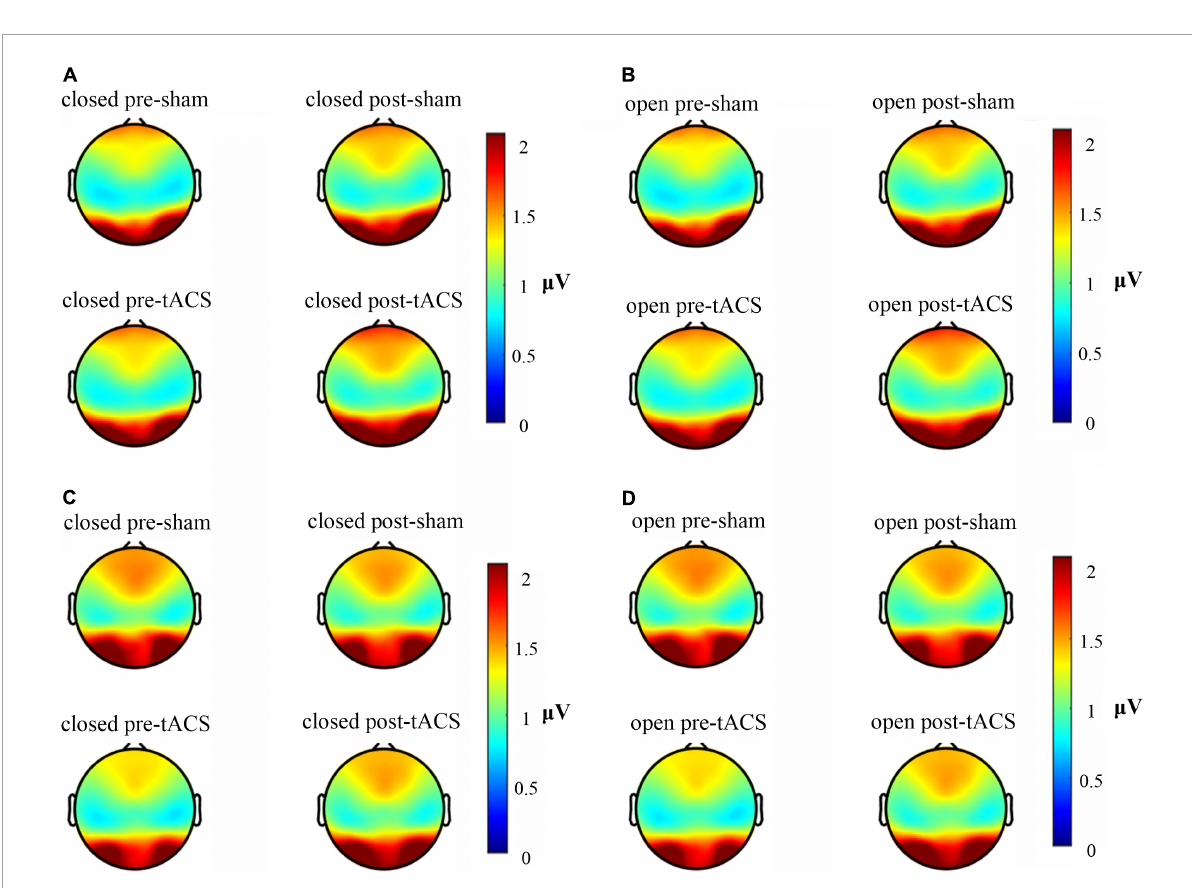
FIGURE3 Brain electrical activity mappings in the alpha frequency band under different stimulation conditions. (A) Topographic map of 1-mA current intensity with the eyes-closed condition. (B) Topographic map of 1-mA current intensity with the eyes-open condition. (C) Topographic map of 2-mA current intensity with the eyes-closed condition. (D) Topographic map of 2-mA current intensity with the eyes-open condition.